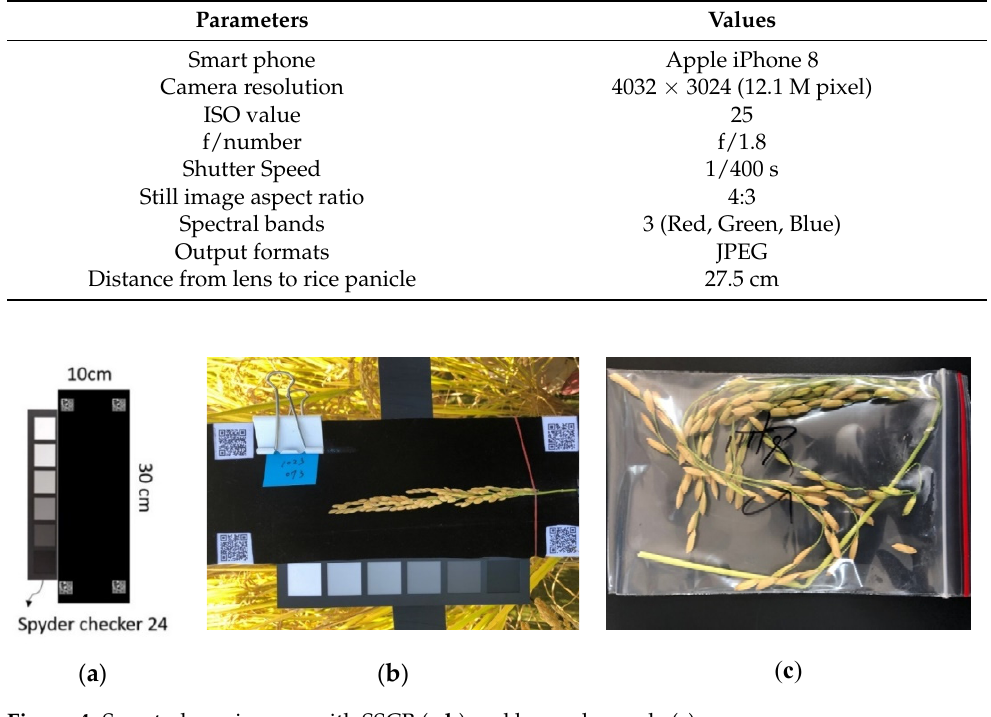
Figure 4. Smart phone images with SSCB ( a , b ) and bagged sample ( c ). Table 2. Smart phone and camera parameters.